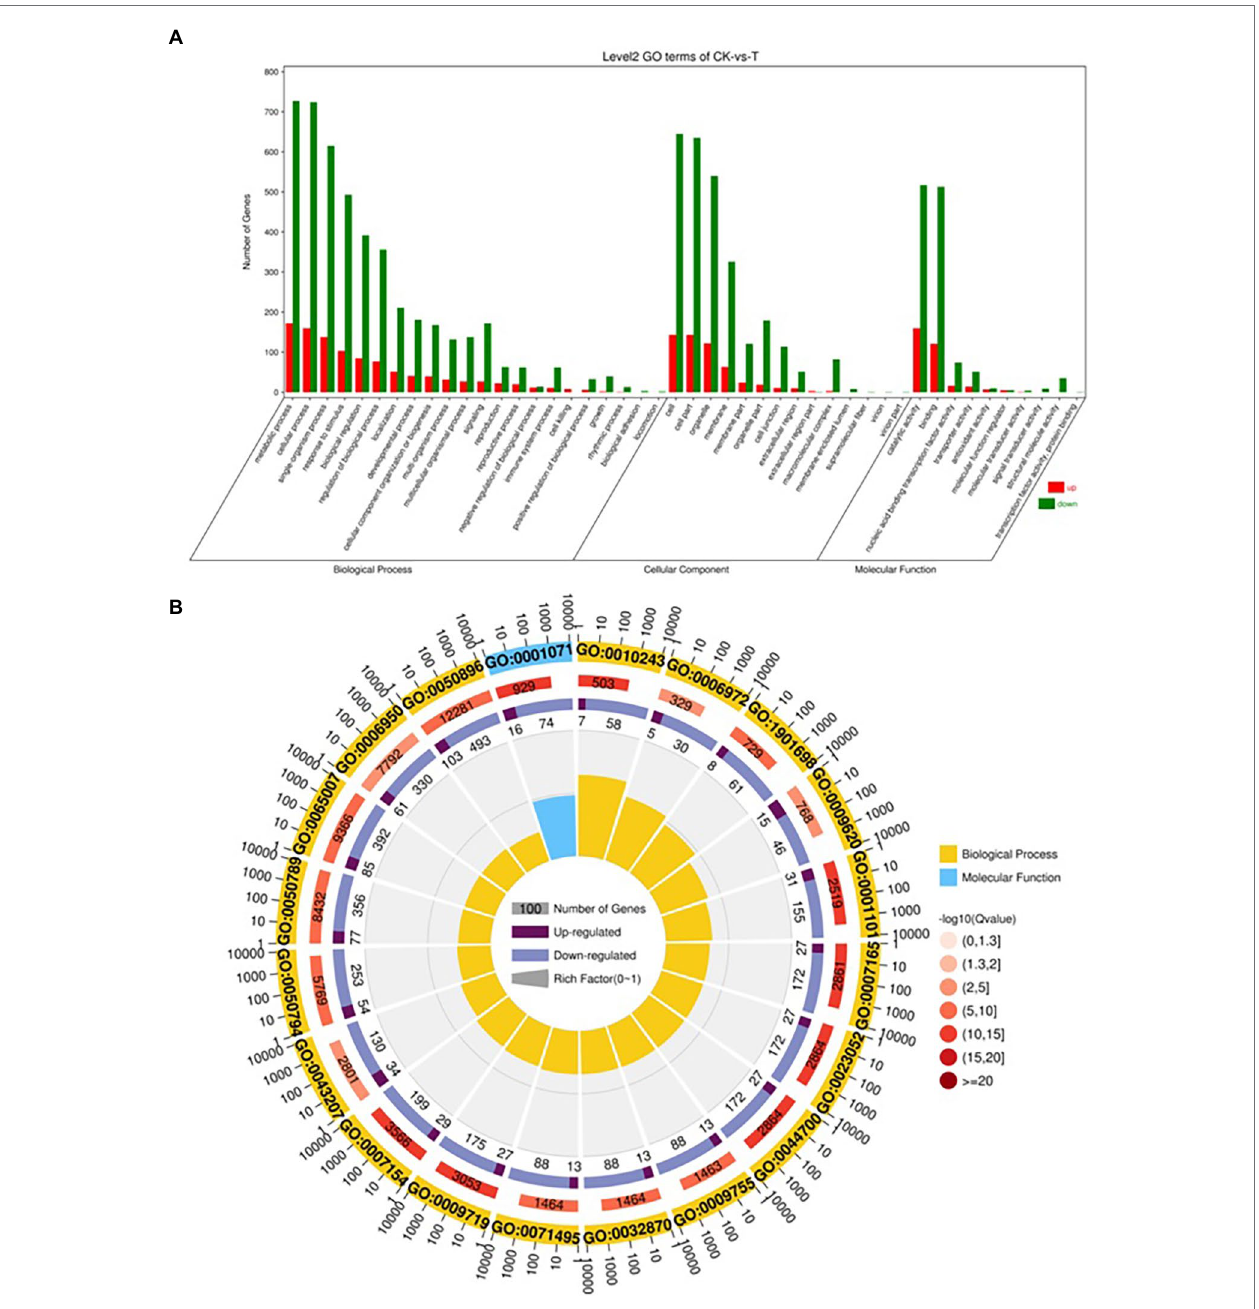
FIGURE 8 | Gene classification was based on Gene Ontology (GO) analysis for differentially expressed genes (DEGs). Different classes are shown for biological processes, cellular components, and molecular functions (A) . GO Rich Circle Map (B) : (First lap: The pathway of the top 20 riches, the coordinates of the number of genes outside the circle.) Different colors represent different classes; Second lap: the number of pathways in the background gene and the Q value. The longer the gene, the smaller the Q value, the redder the color; the third circle: the upper reduction gene scale bar chart, dark purple represents the increase of the gene ratio, the light purple represents the reduction of the gene ratio; the specific values are shown below; the fourth circle: the number of differential genes in each pathway divided by all quantities), the background grid line, each grid represents